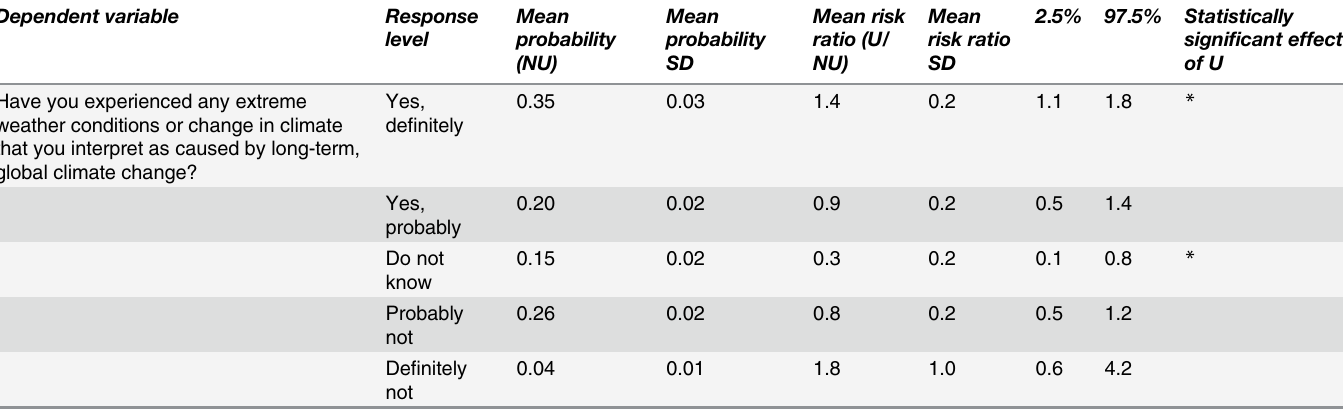
Table 7. Predicted probabilities for strengths of belief in the local effects of climate change based on no university education and relative risk ratios for strengths of belief in having experienced the effects of climate change based on education level (have/have not university education) among German respondents (S8